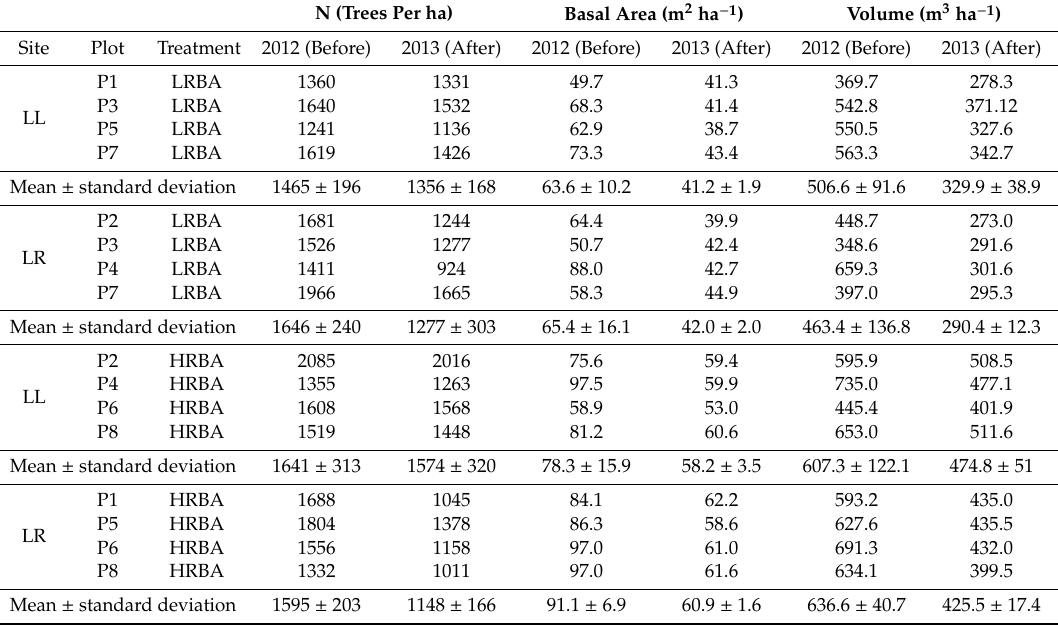
Table 3. Numbers of trees and basal area in all plots selected for the study before and after the selection cuttings. LRBA: Low residual basal area; HRBA: high residual basal area. Notice that original values were lower in the LRBA